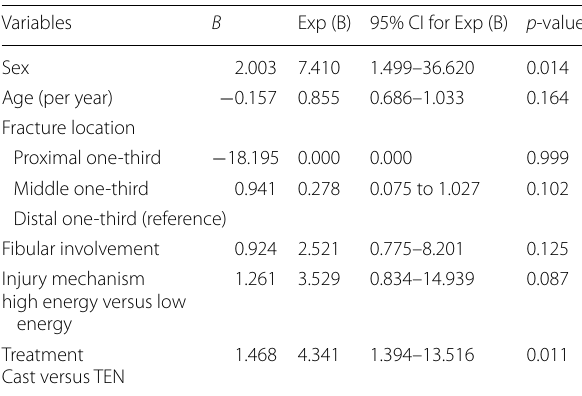
Table 5 Risk factors for leg length discrepancy ( pediatric tibial shaft fracture